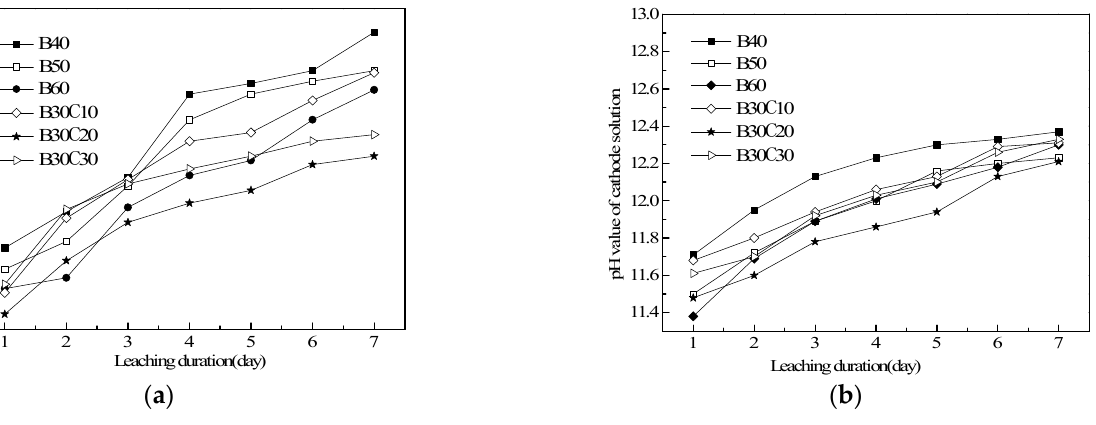
Figure 5. Relationship between pH value of cathode solution and leaching duration. ( a ) first week ( b ) second week.